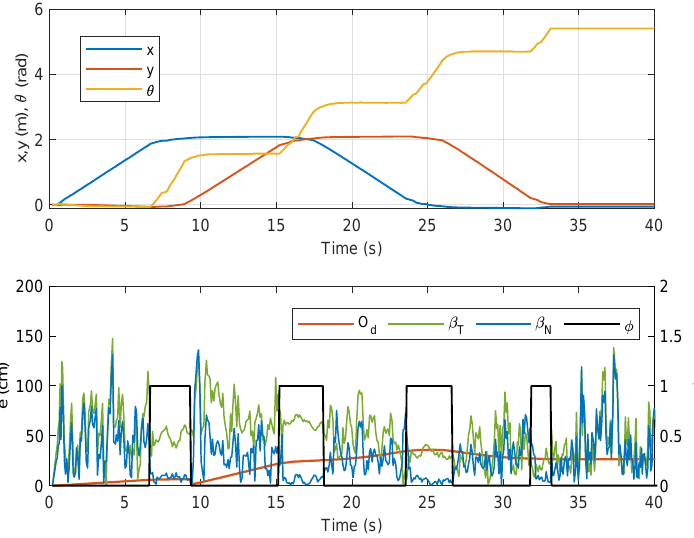
Figure 6. Position of NSBot2 in terms of x , y and θ based on odometry ( top ); temporal localization-error analysis ( bottom